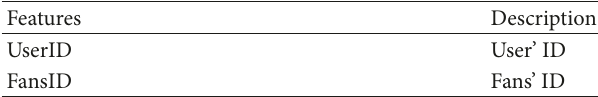
Table 3: Data structure and description of the user